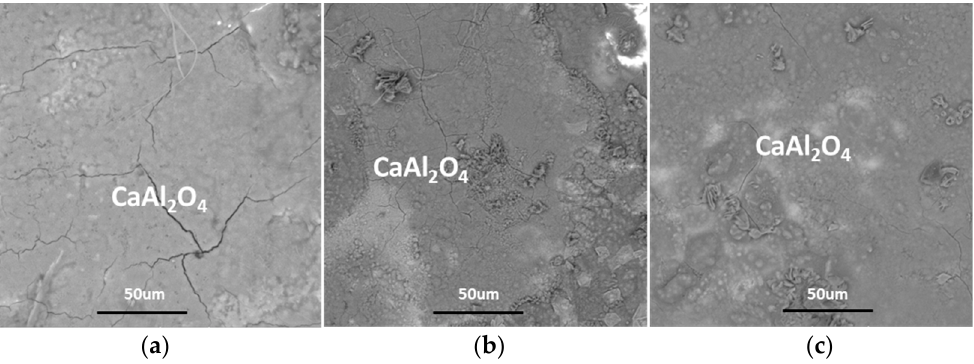
Figure 10. SEM micrographs of the CaO–Al 2 O 3 -based mold flux after DSC measurements: ( a ) 5 °C·min − 1 , ( b ) 30 °C·min − 1 , and ( c ) 50 °C·min − 1 .